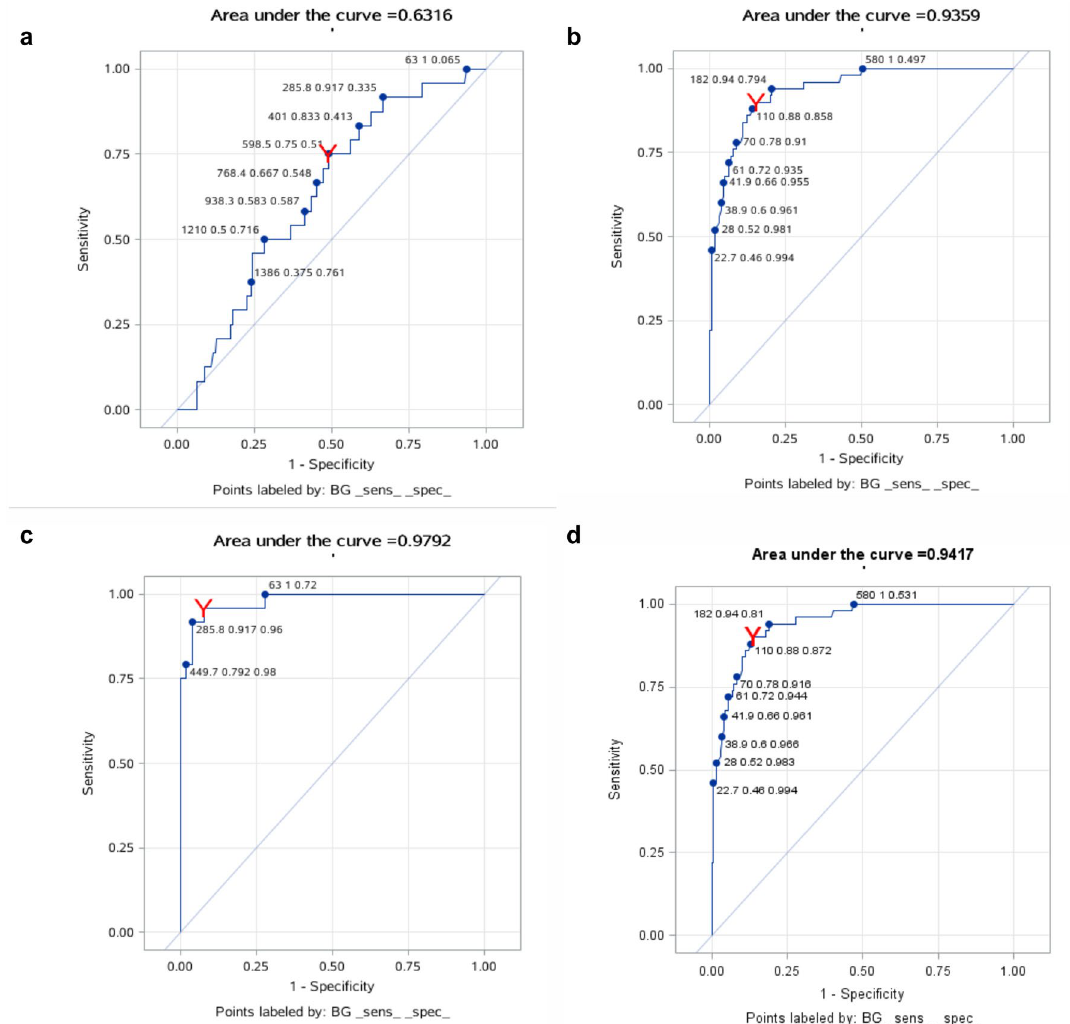
Figure 4. ( a ) The ROC curves for BG of probable PCP and proven PCP groups; ( b ) The ROC curves for BG of probable PCP and NO PCP groups; ( c ) The ROC curves for BG of proven PCP and NO PCP groups; ( d ) The ROC curves for BG of proven/probable PCP and NO PCP